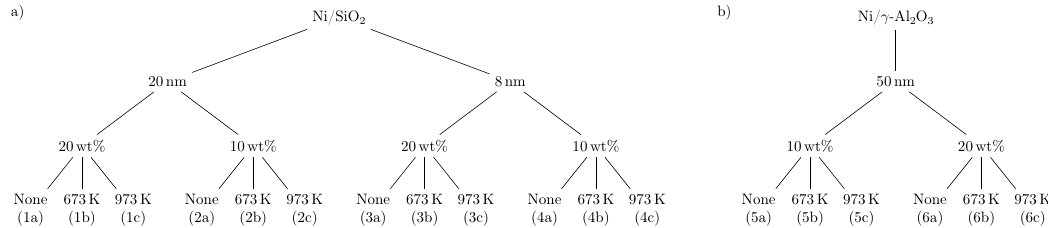
Figure 1. Tree for the production of the ( a ) Ni/SiO 2 and ( b ) Ni/ γ -Al 2 O 3 catalysts. The first node is the size of the primary particles (SiO 2 or Al 2 O 3 ) of the support in the colloidal suspension, the second node is the Ni loading, and the third child node is the temperature of the thermal treatment after the synthesis. The names of the samples are placed in